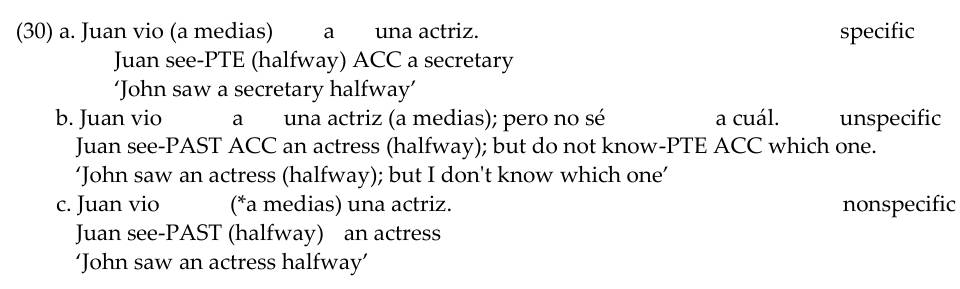
Figure 18. Before insertion of v*, inheritance, Agree, and